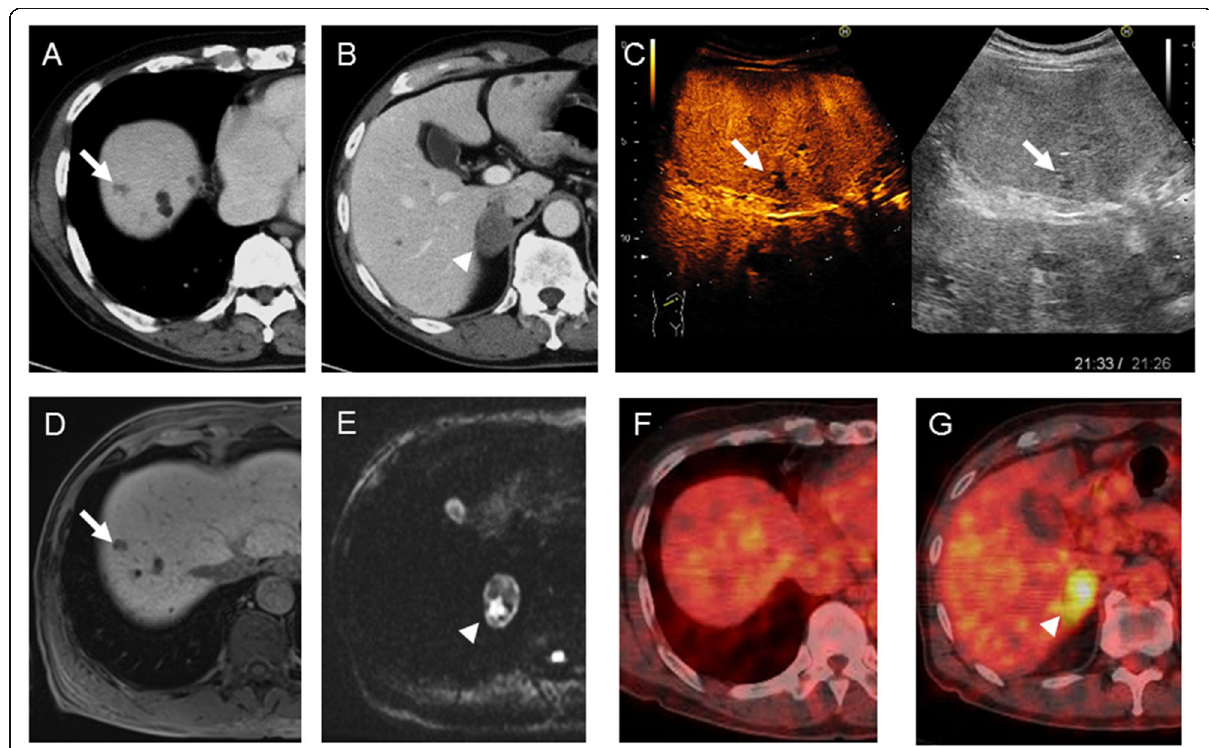
Fig. 1 a , b Computed tomography image showing an about 1.5-cm, irregularly shaped mass lesion in segment 8 of the liver (arrow), and about 3.0-cm right adrenal gland tumor having inferior vena cava (IVC) tumor thrombus (arrow head). c Contrast-enhanced ultrasonography image indicating a defect on the Kupffer phase in segment 8 (arrow). d , e Gadolinium-ethoxybenzyl-diethylenetriamine pentaacetic acid magnetic resonance images showing a defect on the hepatobiliary phase at about the liver tumor (arrow) and a high intensity on diffusion-weighted imaging about the right adrenal tumor (arrowhead). f, g 18 F-fluorodeoxyglucose-positron emission tomography showing abnormal accumulation (maximum standard uptake value 5.6) in the adrenal tumor (arrowhead), but no abnormal accumulation was observed in the